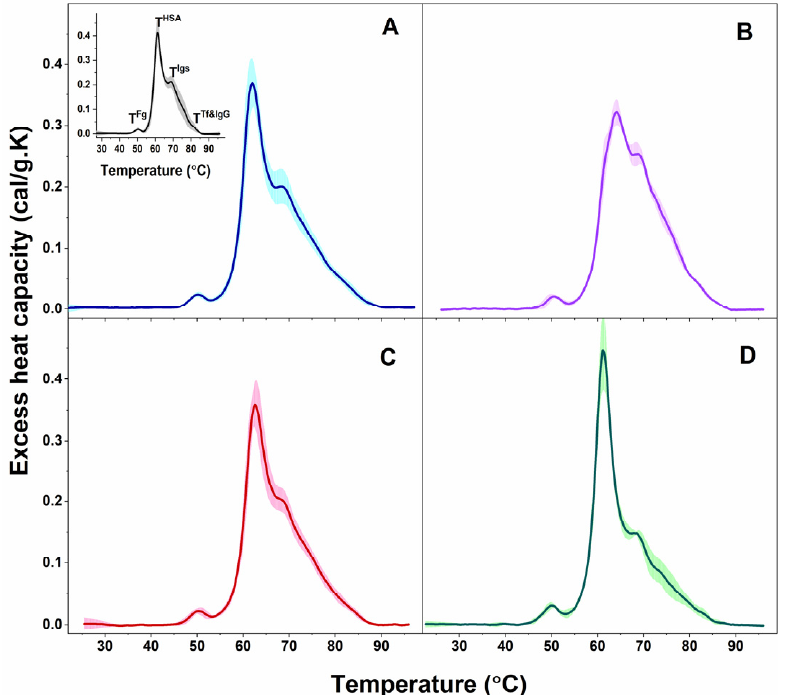
Figure 1. Calorimetric profiles of blood plasma clustered for PD patients in PD1 ( A ) and PD2 ( B ) sets and for ALS patients in ALS1 ( C ) and ALS2 ( D ) sets. Mean scans (solid lines) and SD (shadows). For comparison, the average plasma scan and SD of plasma from healthy individuals (black solid line and grey shadow) are shown in inset of panel A; the temperatures of the thermal transitions assigned to the most abundant plasma protein (T Fg , T HSA , T Igs , and T Tf&IgG ) are also denoted. The observed transitions were denoted T Fg , T HSA , T Igs , and T Tf&IgG , according to their assignment to the most abundant plasma proteins: T Fg to fibrinogen (Fg), T HSA to albumin (HSA), T Igs to immunoglobulins (Igs), and T Tf&IgG to transferrin (Tf) and immunoglobulin G (IgG). Proteins, present in lower concentrations in plasma (including complement proteins, haptoglobin, α -2-macroglobulin, α -1-antitrypsin, α -1-chymotrypsin, and others) can